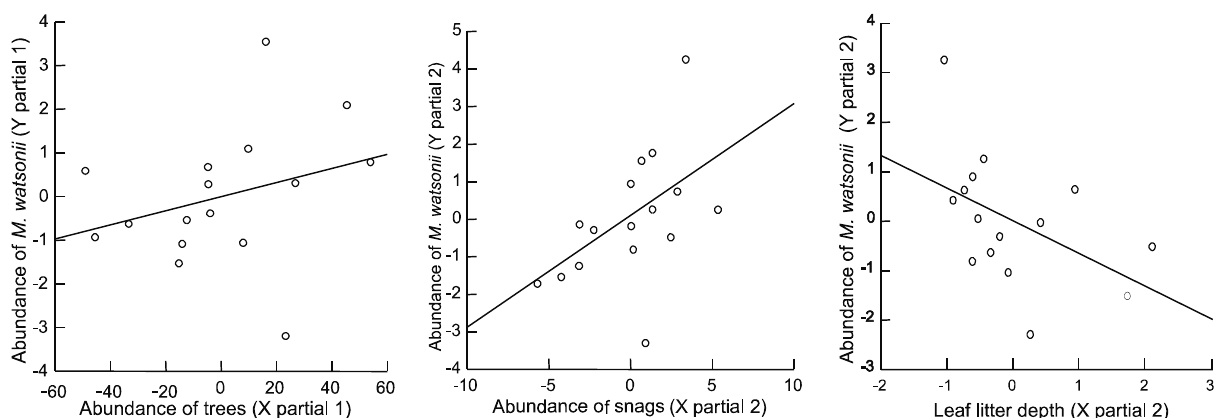
Figure 7. Partials of multiple linear regressions on abundance of the tawny-belied owl M. watsonii in relation to abundance of snags, abundance of trees and leaf litter depth. Some numbers in the axes are negative because the partial regression represents the deviation of the expected results if all the other independent variables are kept constant in their observed means. Because we presented graphs only for those forest components that had significant effects on bird abundance and each of them were constructed with data from different multiple regression models with various forest structure components, the number of the partials of the regressions within parenthesis are the same in the two